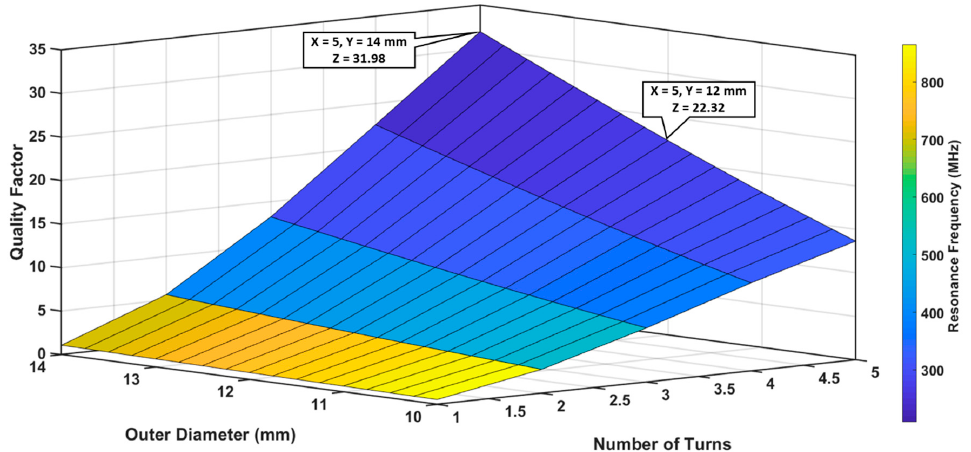
Figure 7. Analysis of S 2 quality factor and resonance frequency for different number of turns and outer diameters, when trace separation was 500 μ m and trace width was 200 μ m.